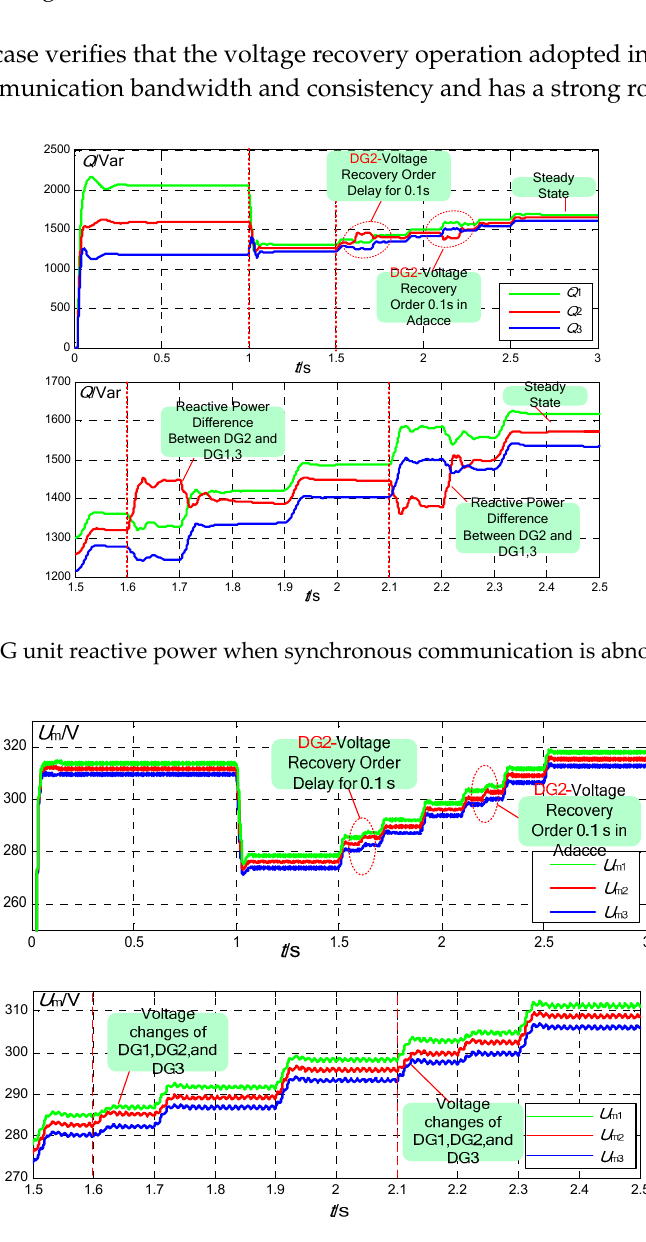
Figure 7. Simulated results of Test 2.